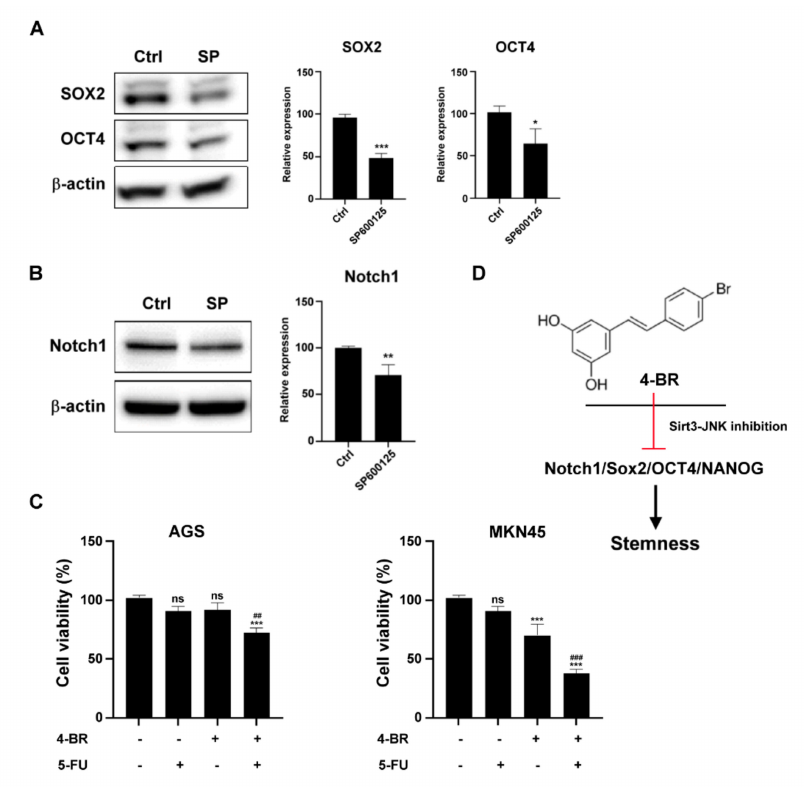
Figure 4. 4-BR contributes to the inhibition of JNK-mediated cancer stemness and increases chemosen- sitivity to 5-FU. ( A ) JNK inhibitor SP600125 (SP; 20 µ M) inhibited stemness transcriptional factors and Notch1 in MKN45. ( B ) Quantification of stemness transcriptional factors and Notch1 after JNK inhibitor treatment for 48 h. ( C ) The cell viability of AGS or MKN45 was evaluated through a Cell Counting Kit assay with 5-FU (0.5 µ M), 4-BR (25 µ M), or a combination of 5-FU and 4-BR. ( D ) Role of 4-BR in gastric cancer stemness inhibition. Data are presented as means ± standard error; n ≥ 3 independent